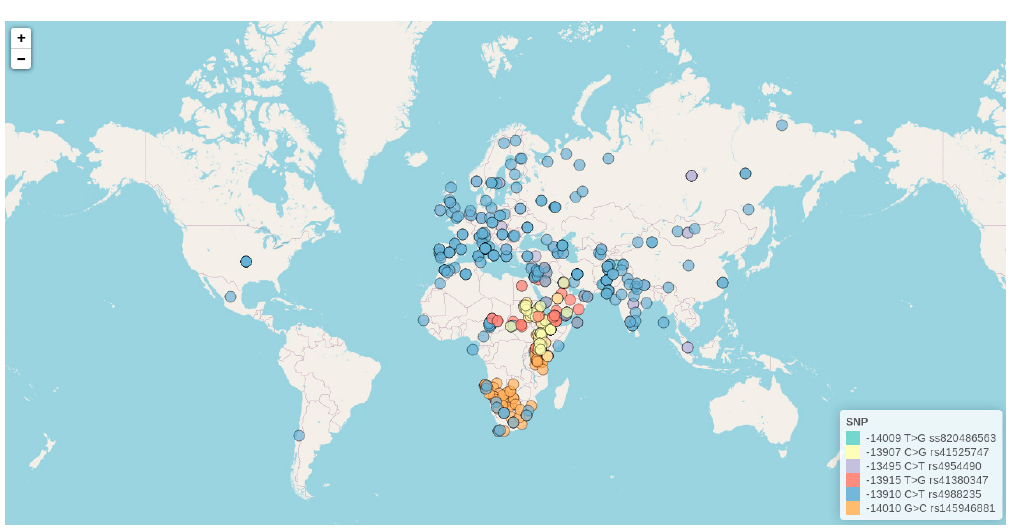
Figure 4. Interactive map exploring worldwide allele frequencies for the most studied lactase persistence (LP)-associated genetic variants (http://bionit.ugr.es/pages/investigacion/software/bioinformatics-methods-software). Data for each SNP are represented by a different color. It also offers a detailed description for each included study (incorporating information related to geographical location, ethnicity, frequency of LP-associated alleles, and literature references). The figure presented here represents a static capture of the interactive map.